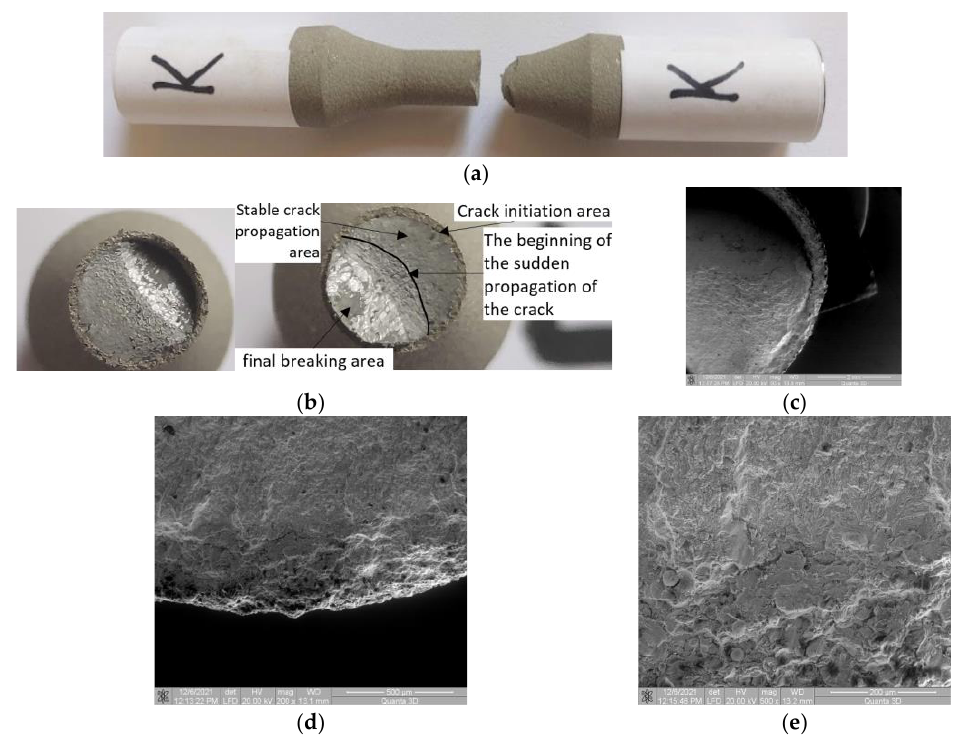
Figure 9. Macroscopic images of broken surfaces for the samples K and L. ( a ) Specimen K: Side view of the broken sample. ( b ) Specimen K: Macroscopic images of surfaces resulting from break- age. ( c ) Specimen K: SEM image (50×) of the broken surface at plane deflection. ( d ) Specimen K: SEM image (200×) of the interface area. ( e ) Specimen K: SEM image (500×) with damage in the interface area.